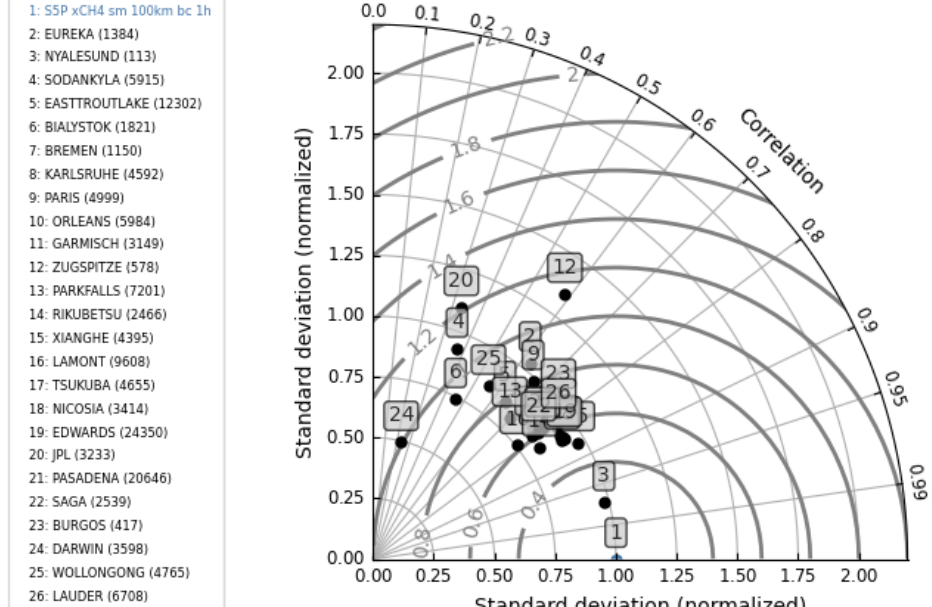
Figure 8. Taylor diagram for daily mean differences between S5P bias-corrected XCH 4 and TCCON XCH 4 data with a priori alignment at the 25 TCCON stations within the period between November 2017 and September 2020. Spatial co-location with radius of 100km and time of ± 1h around the satellite overpass was used. The stations are sorted with decreasing latitude.